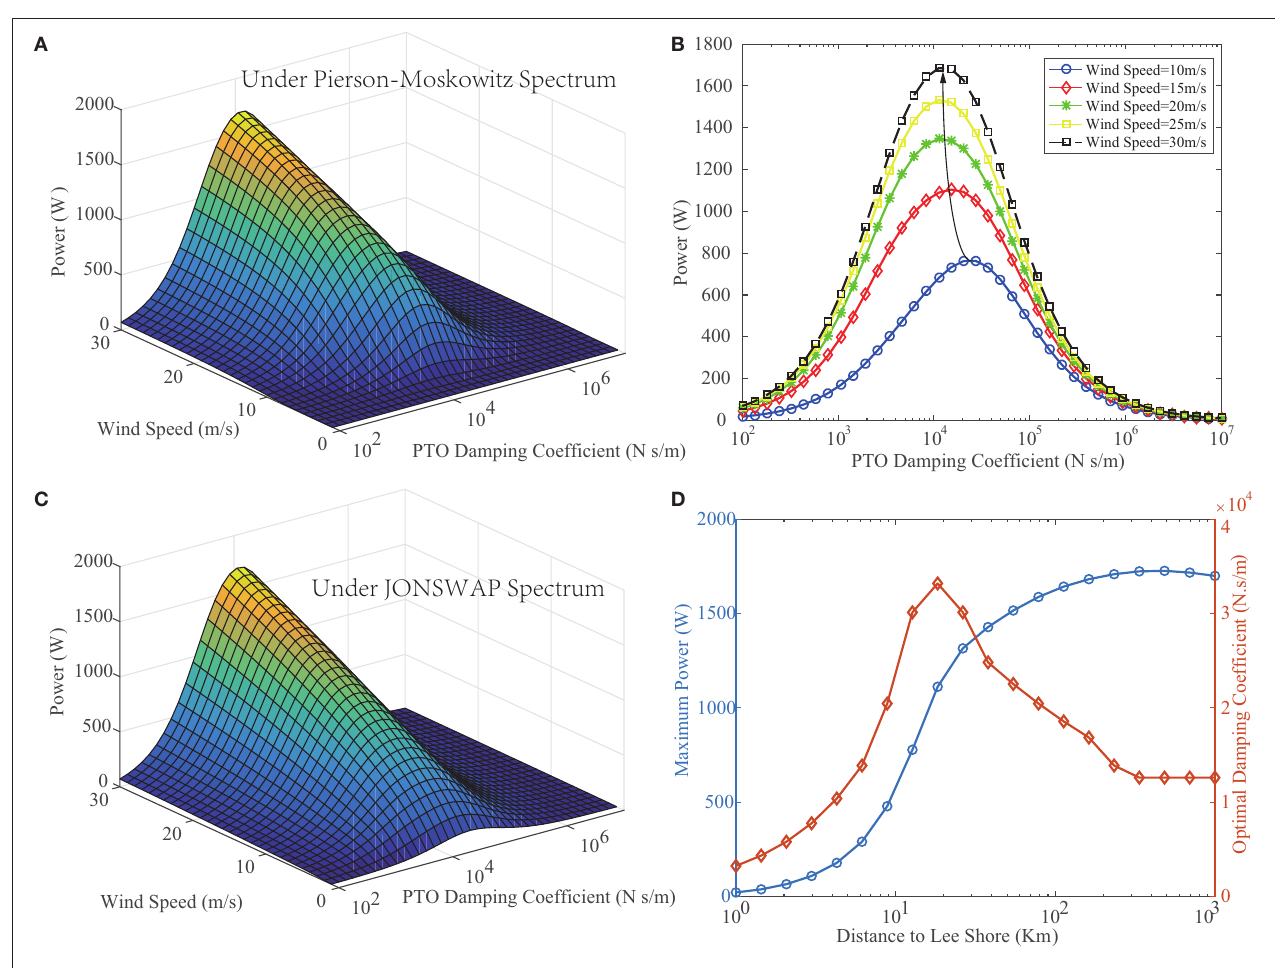
FIGURE 10 | The influence of the wind speed and the equivalent PTO damping coefficient on the generated power. (A) Dependence of the extracted power on the wind speed and the PTO damping coefficient under the Pierson-Moskowitz spectrum. (B) The relationship between the power and the PTO damping coefficient at various wind speeds under the Pierson-Moskowitz spectrum. (C) Dependence of the extracted power on the wind speed and the PTO damping coefficient under the JONSWAP spectrum. (D) Influence of the distance to the lee shore on the maximum power and the optimal damping coefficient.